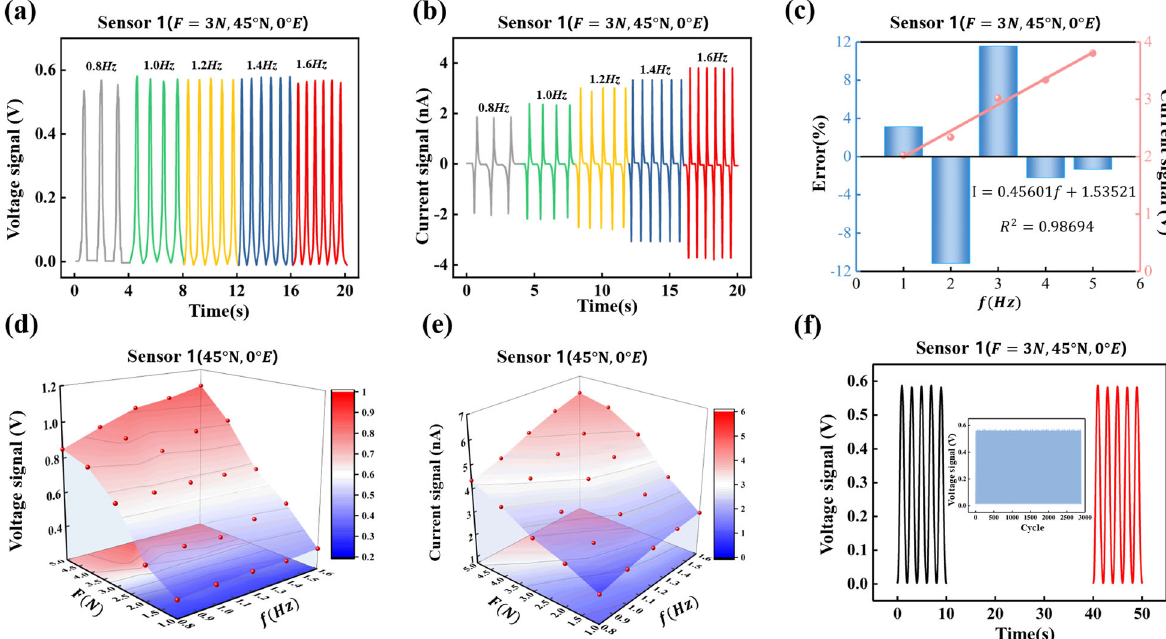
Fig. 3 Characterization of the sensing unit. a The open-circuit voltage responding to collision frequencies from 0.8 Hz to 1.6 Hz. b The short circuit current responding to collision frequencies from 0.8 Hz to 1.6 Hz. c Fitted linear relationship between short circuit current and collision frequencies. d Relationship between the output voltage of the TPTS, load magnitude, and collision frequency. e Relationship between the output current of the TPTS, load magnitude, and collision frequency. f The durability of the TPTS tested for 2800 cycles.